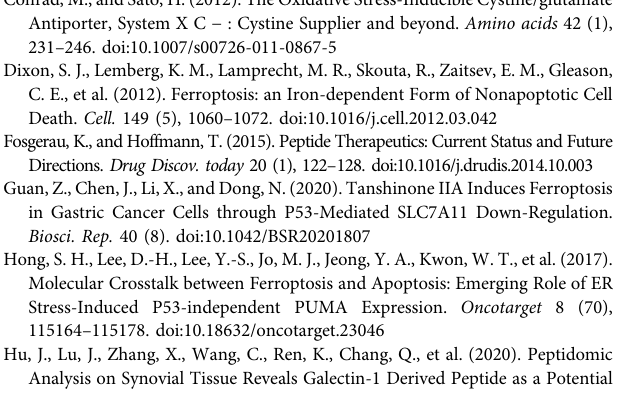
Supplementary Figure SA | Western blot analysis of protein expression of p53. MH7A were pretreated with p53-siRNA or siRNA. **p < 0.01. Supplementary Figure SB | Western blot analysis of protein expression of Caspase3. MH7A were pretreated with Caspase3-siRNA or siRNA. **p <